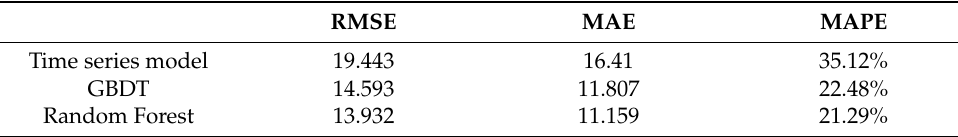
Table 11. Comparison of the model prediction